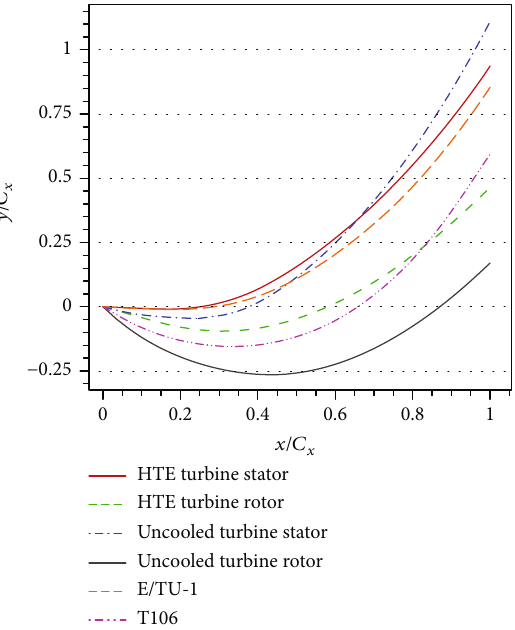
Figure 2: Turbine blade camber